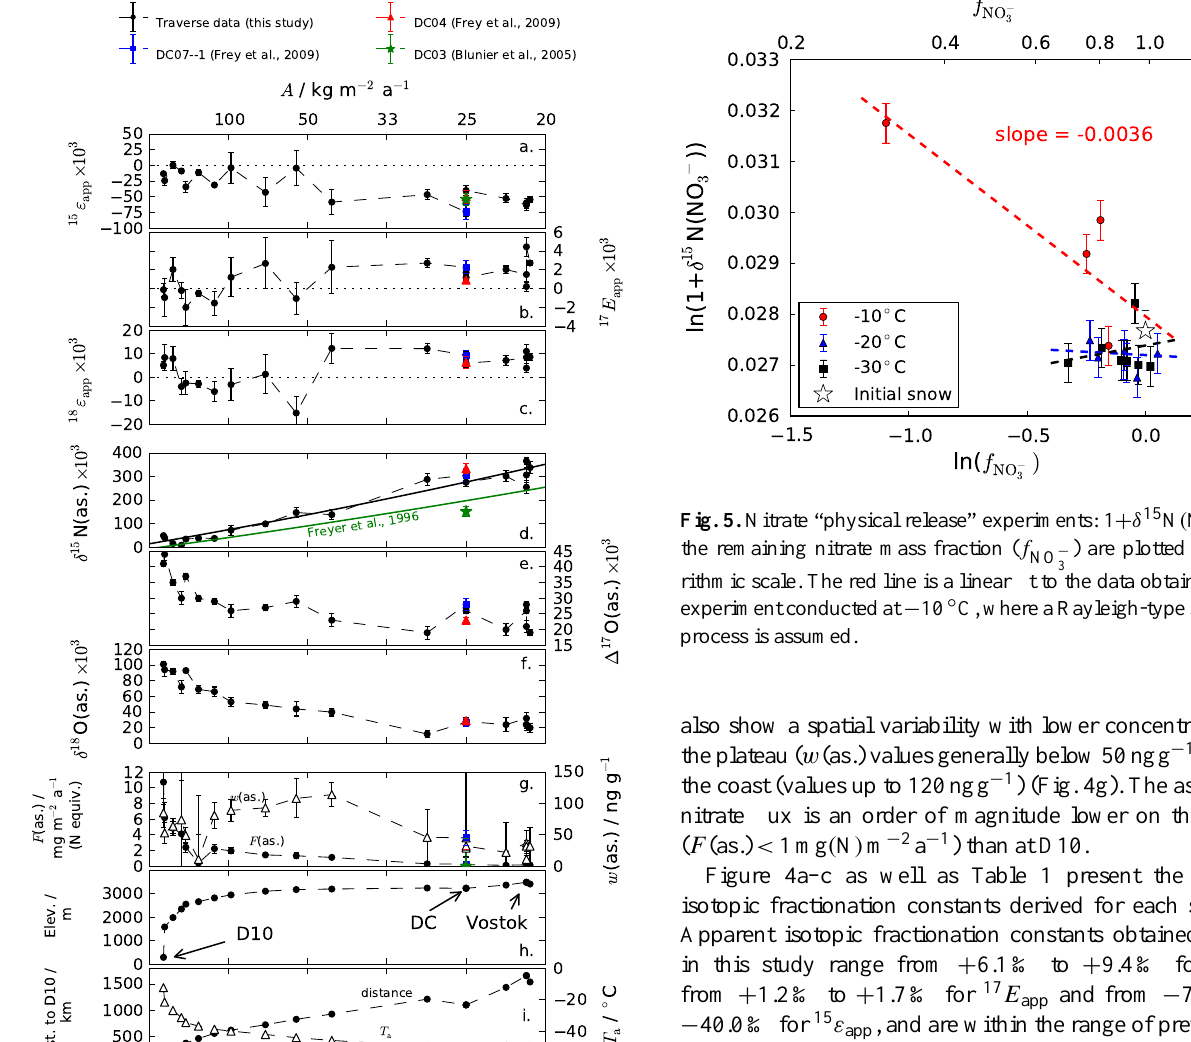
Fig. 5. Nitrate “physical release” experiments: 1 + δ 15 N ( NO − the remaining nitrate mass fraction ( f rithmic scale. The red line is a linear fit to the data obtained for the experiment conducted at − 10 ◦ C, where a Rayleigh-type single loss process is